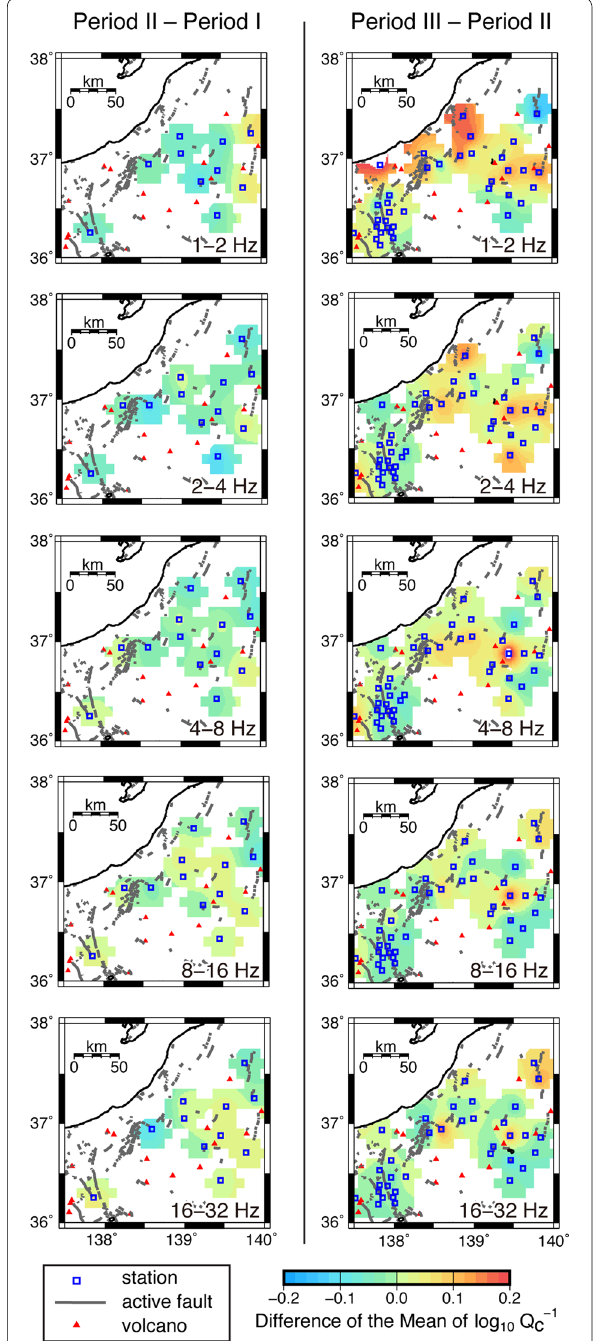
Fig. 5 Spatial distributions of the difference of the mean of log 10 Q C − 1 for the successive two periods at each frequency band; left panels between the period II and the period I, and right panels between the period III (Dojo and Hiramatsu 2017) and the period II. Blue squares are stations, at which we obtain the value of coda Q for more than 10 events in each period, used to draw the map. Gray lines show Quaternary active faults, and red triangles show Quaternary active volcanoes